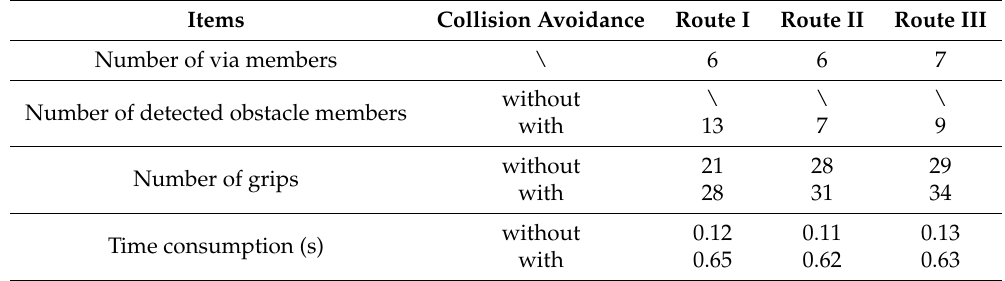
Table 2. Comparison of results of grip planning with and without the consideration of collision avoidance. Items Collision Avoidance Route I Route II Route III Number of via members \ 6 6 7 without \ \ \ Number of detected obstacle members with 13 7 9 without 21 28 29 Number of grips with 28 31 34 without 0.12 0.11 0.13 Time consumption (s) with 0.65 0.62